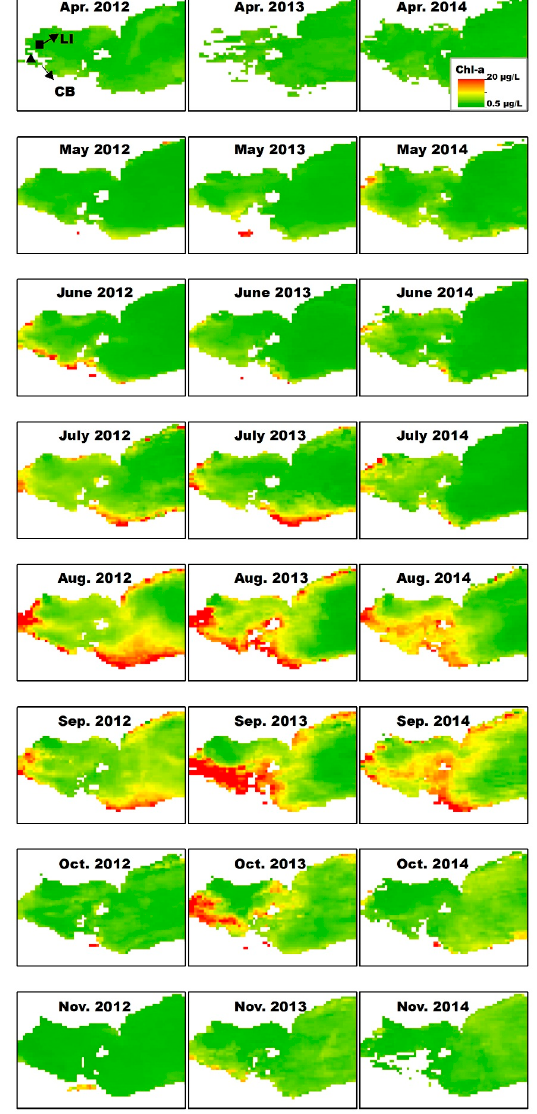
Figure 3. The monthly mean chlorophyll-a concentration estimated based on MODIS images for